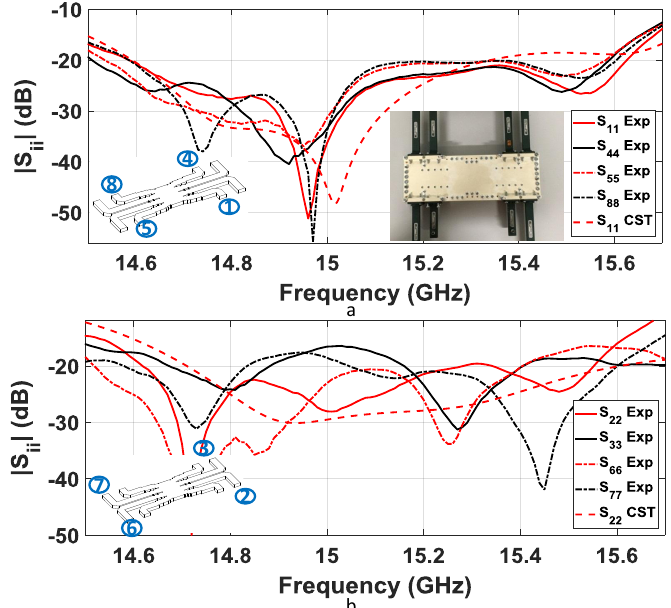
Figure 6. Experimental results for the return loss for the eight ports. ( a ) Ports 1, 4, 5, and 8. ( b ) Ports 2, 3, 6, and 7. The numbering of the ports is shown in the inset of the figure. Simulation results are presented with dashed